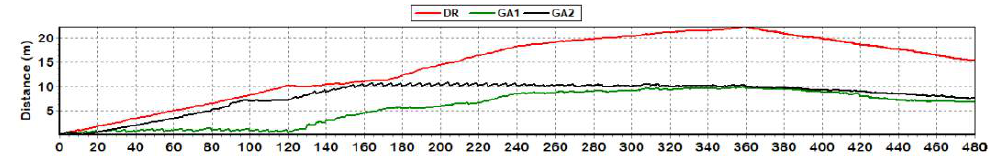
Figure 5. Reference and DR, GA1, GA2 estimated paths of vehicle F obtained in the course of conducting: ( a ) single test sample; ( b ) hundred test samples.